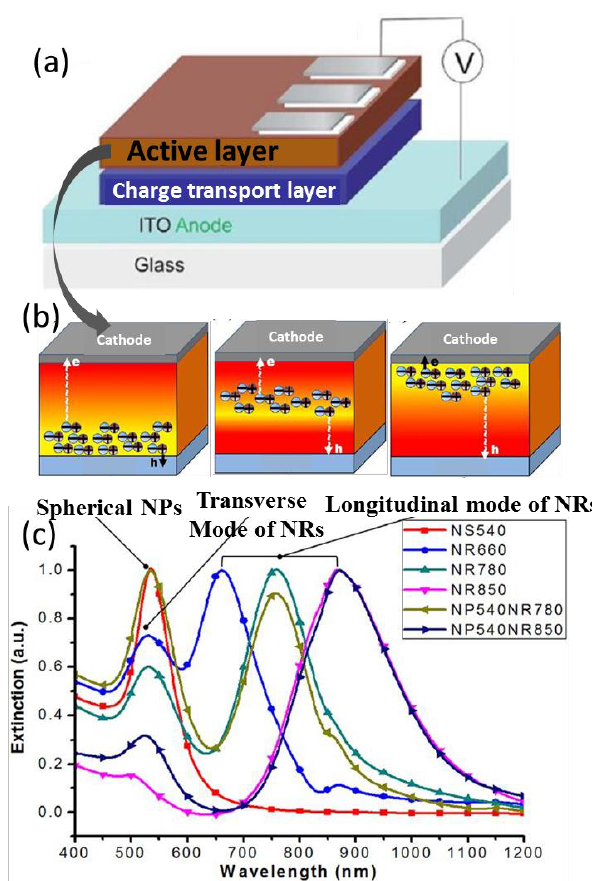
Figure 4. ( a ) Schematic illustration of the sandwich-type BHJ solar cell; ( b ) Ag NPs located in sublayers of the active layer [84]; ( c ) Up: Dipolar oscillations in spherical Au NPs and Au NRs. Bottom: normalized UV-Vis-NIR absorption spectra of Au NPs of various sizes and shapes in water [83]. Reprinted with permission from Refs. [83,84].